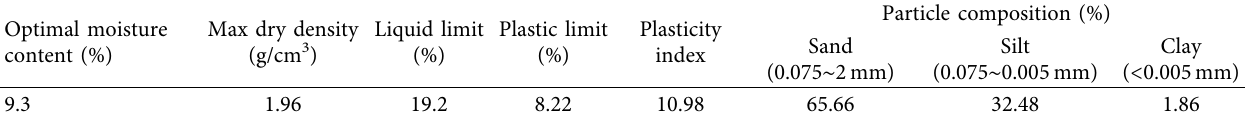
Figure 2: X-ray diffraction patterns (10 ∼ 50 ° /10 ∼ 70 ° ) of silty sand soil (a), lime (b),metakaolin (c), and hydraulic lime (d). Table 1: Basic properties of silty